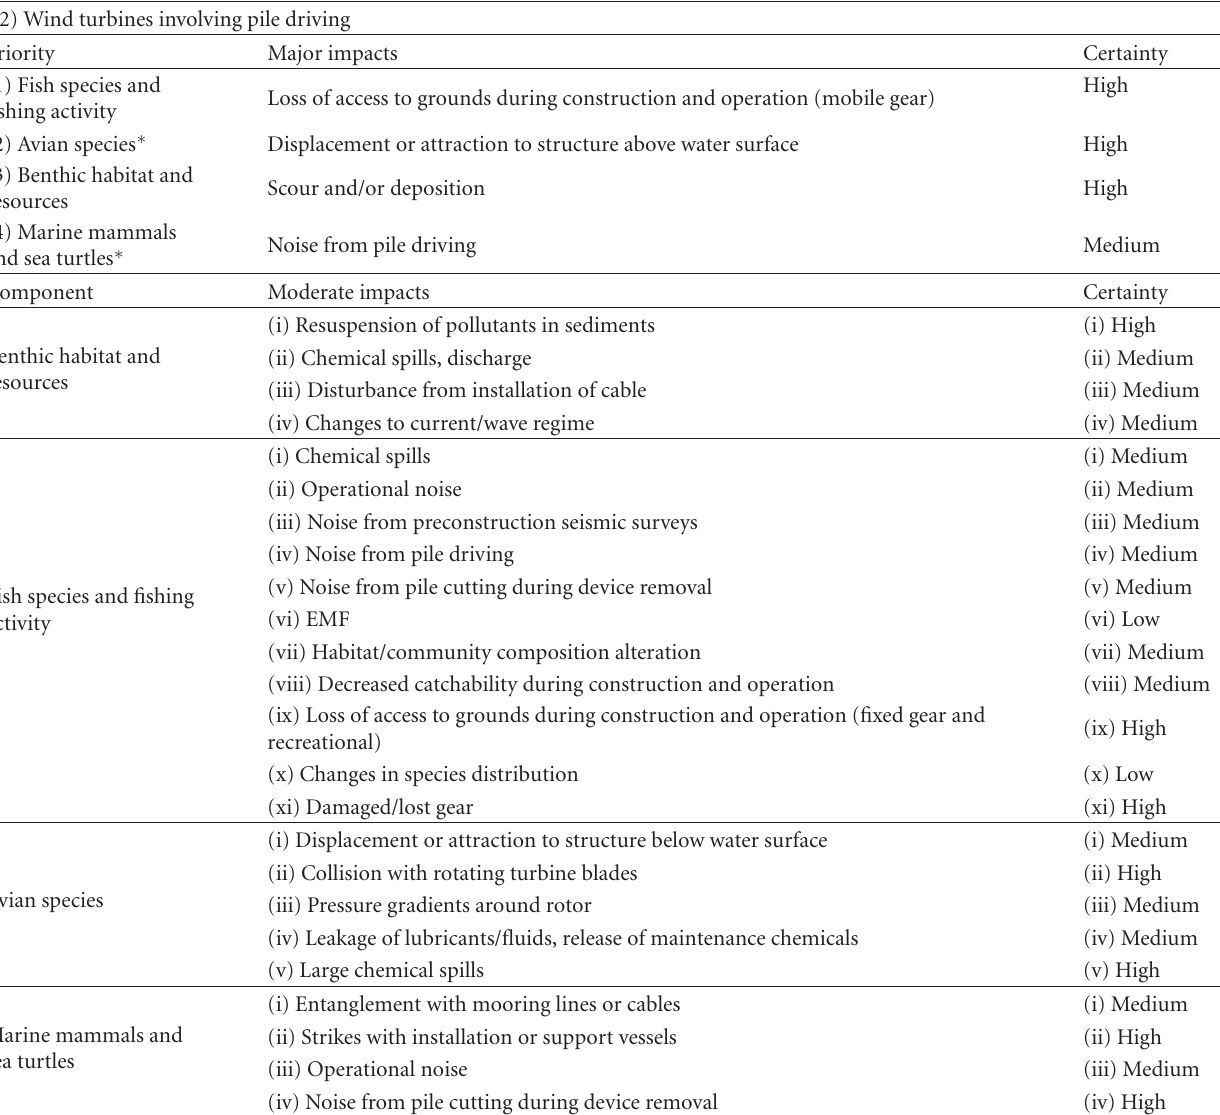
Table 4: A description of the potential impacts resulting from wind turbine projects involving pile driving. See text, Section 3.3, for a narrative summary of this development scenario. Ecosystem components are ranked by their proportion of the major impacts. Moderate impacts are listed in the order they appear in the renewable energy impact